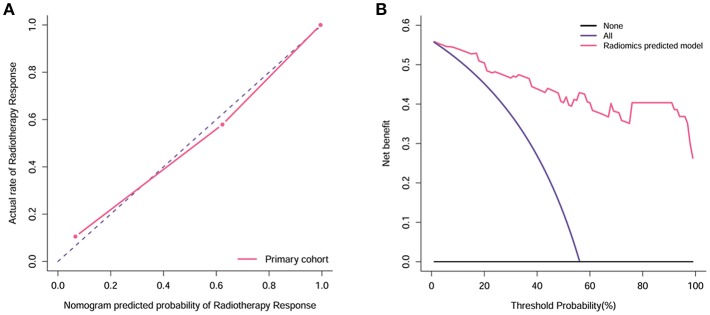
Calibration and decision curve analysis of the radiomics model. (A) The Y-axis represents the actual rate. The X-axis represents the predicted probability. The diagonal violet line represents a perfect prediction by an ideal model. The pink line represents the performance of the radiomics model, which shows a closer fit to the diagonal violet line representing a better prediction. (B) The Y-axis measures the net benefit. The pink line represents the radiomics model. The violet line represents the assumption that all patients showed remission. The black line represents the assumption that no patients showed remission.